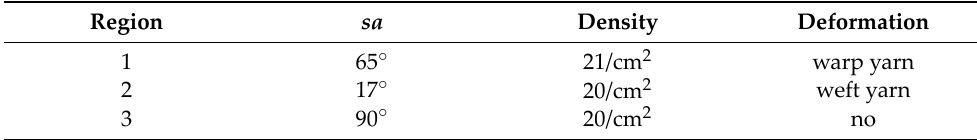
Table 4. NDT results of the UAV Table 3. The contrast of Figures 3–5.